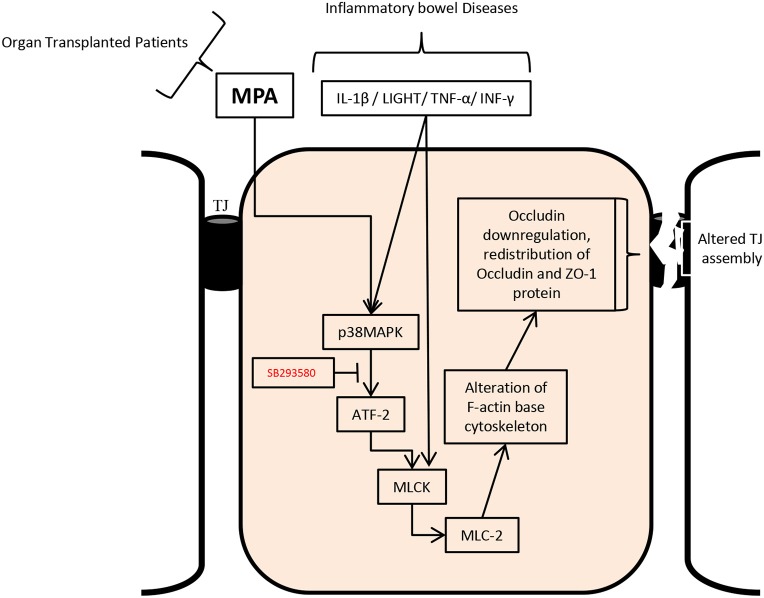
Proposed mechanism of MPA-induced TJs assembly deregulation in Caco-2 cells monolayer. Proinflammatory cytokines (as observed in IBD) directly or through p38MAPK activate the MLCK pathway which leads to the altered TJs proteins contents and composition in TJs assembly, resulting in compromised epithelial barrier function. This compromised barrier function contributes to leaky style diarrhea in IBD patients. Identification of altered chromatin structure at p38MAPK, ATF-2, MLCK, and MLC-2 promoter regions after MPA treatment allow us to assume that MPA either directly or through unknown mediators activates the p38MAPK cascade. Activation of the p38MAPK-dependent MLCK/MLC-2 pathway consequently reorganizes F-actin base cytoskeleton, redistribute ZO-1 and occludin proteins of TJs assembly, resulting in increased permeability of Caco-2 monolayer.